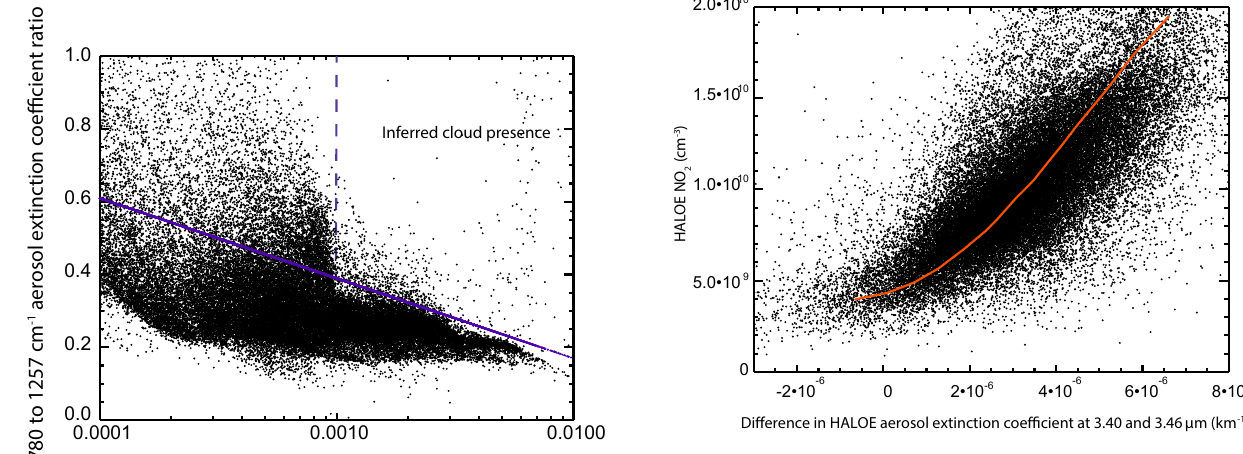
Figure 5. All HALOE NO 2 between 20 and 30km plotted against the corresponding difference between HALOE aerosol extinction coefficient measured at 3.40 and